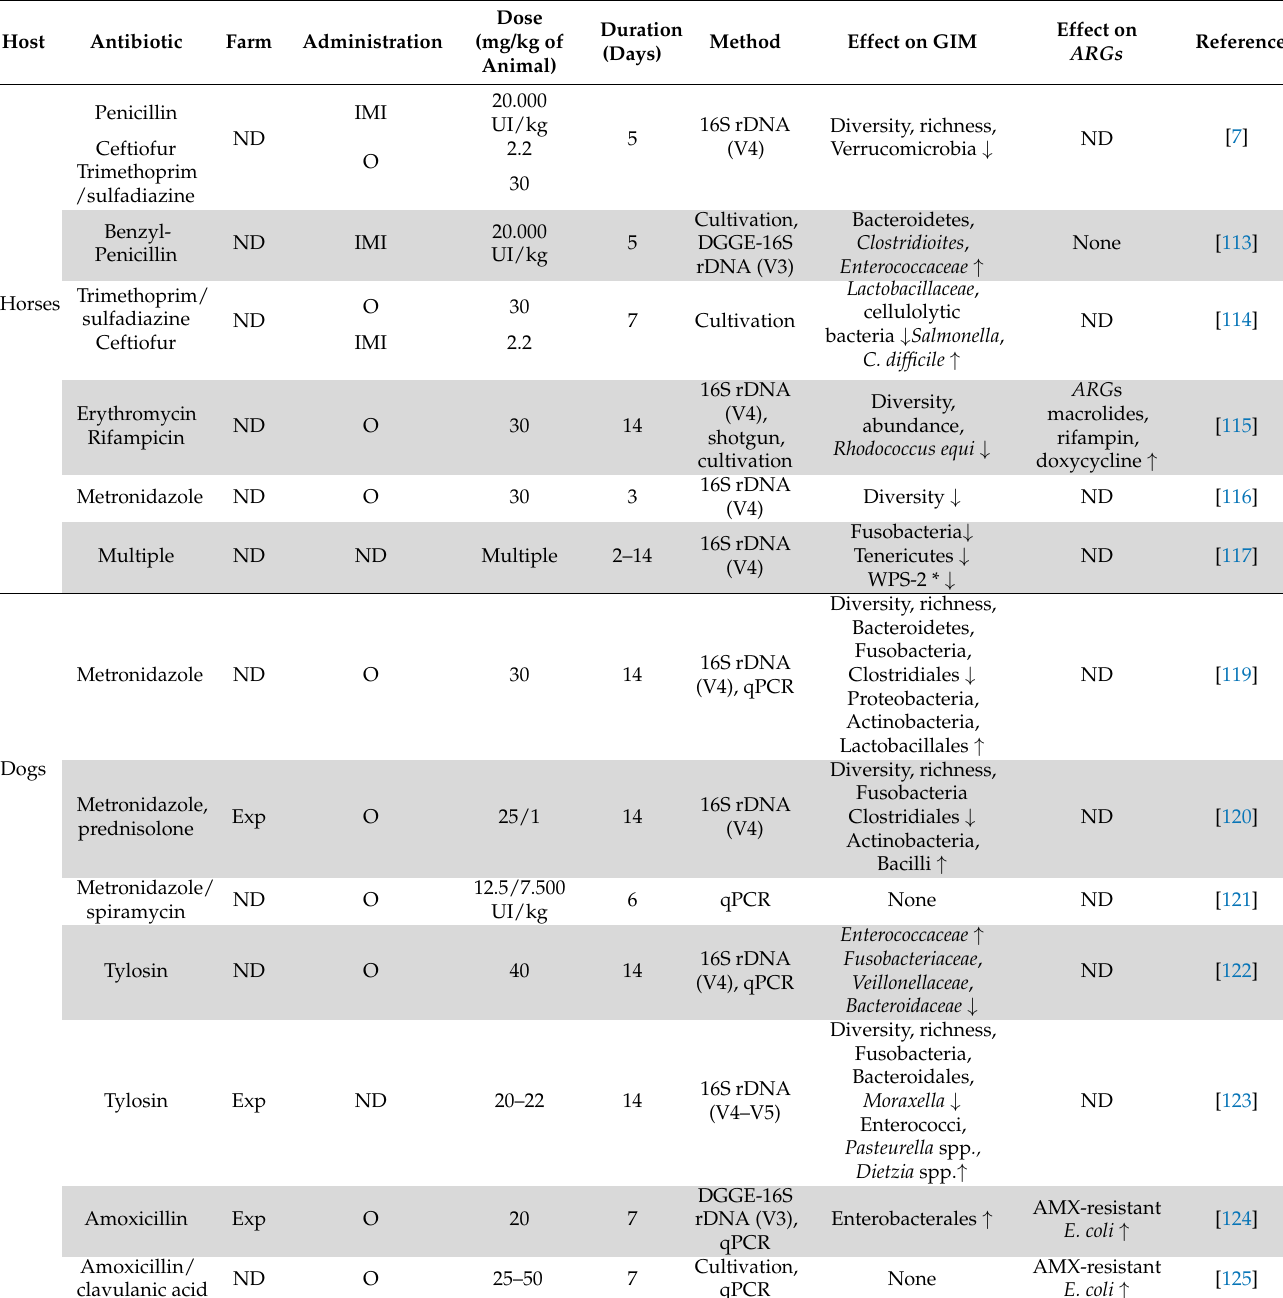
Table 4. Summary of studies investigating impact of antibiotics on companion animals’ intestinal microbiota and relative antibiotic resistance